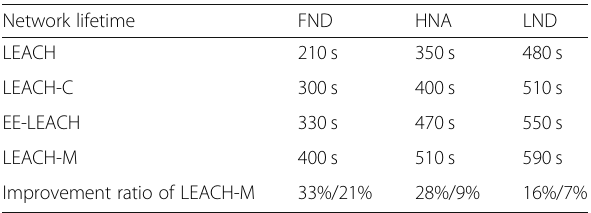
Table 6 The statistics of alive nodes of four algorithms in 300 × 300m